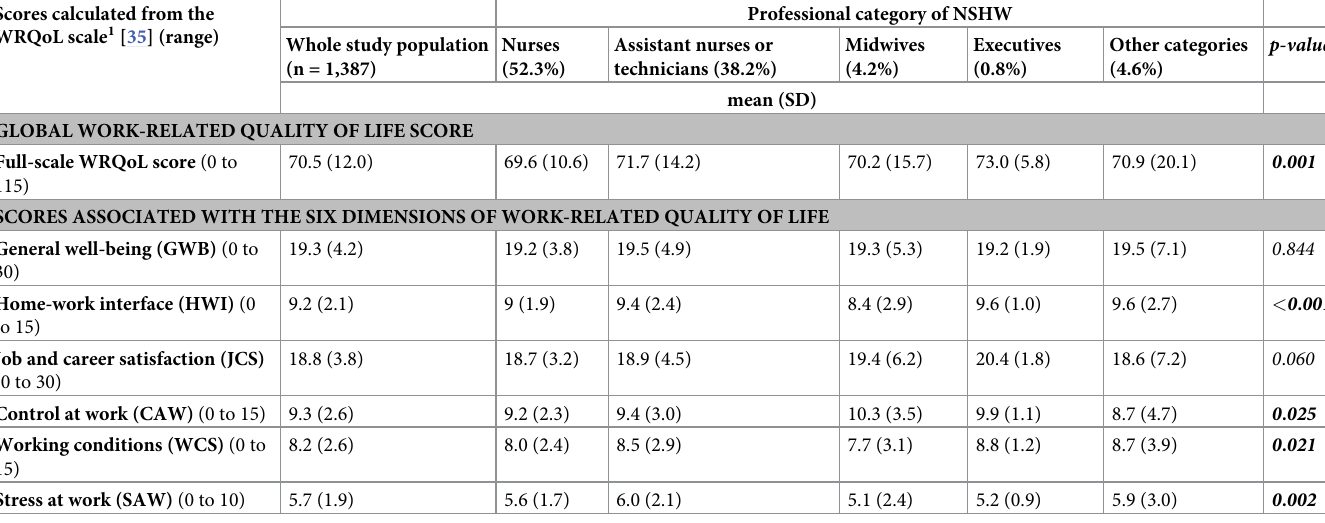
Table 2. Mean quality of working life scores among night-shift healthcare workers according to their professional category (n = 1,387, AP-HP ALADDIN survey, Paris public hospitals). Scores calculated from the WRQoL scale 1 [35] (range)